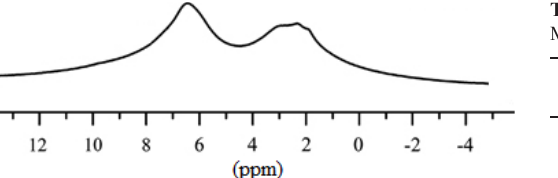
Figure 4. 1 H MAS spectrum of Maghnite-H + (recorded with a π/4 pulse of 3.4 μs, 80 scans, a recycle delay of 4 s and spinning frequencies of 30 kHz.